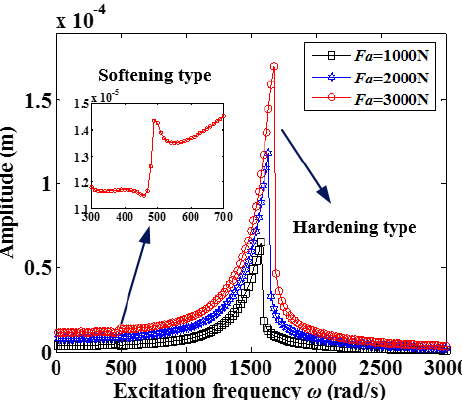
Figure 9. Amplitude-frequency curves of the feed system for different excitation amplitudes.